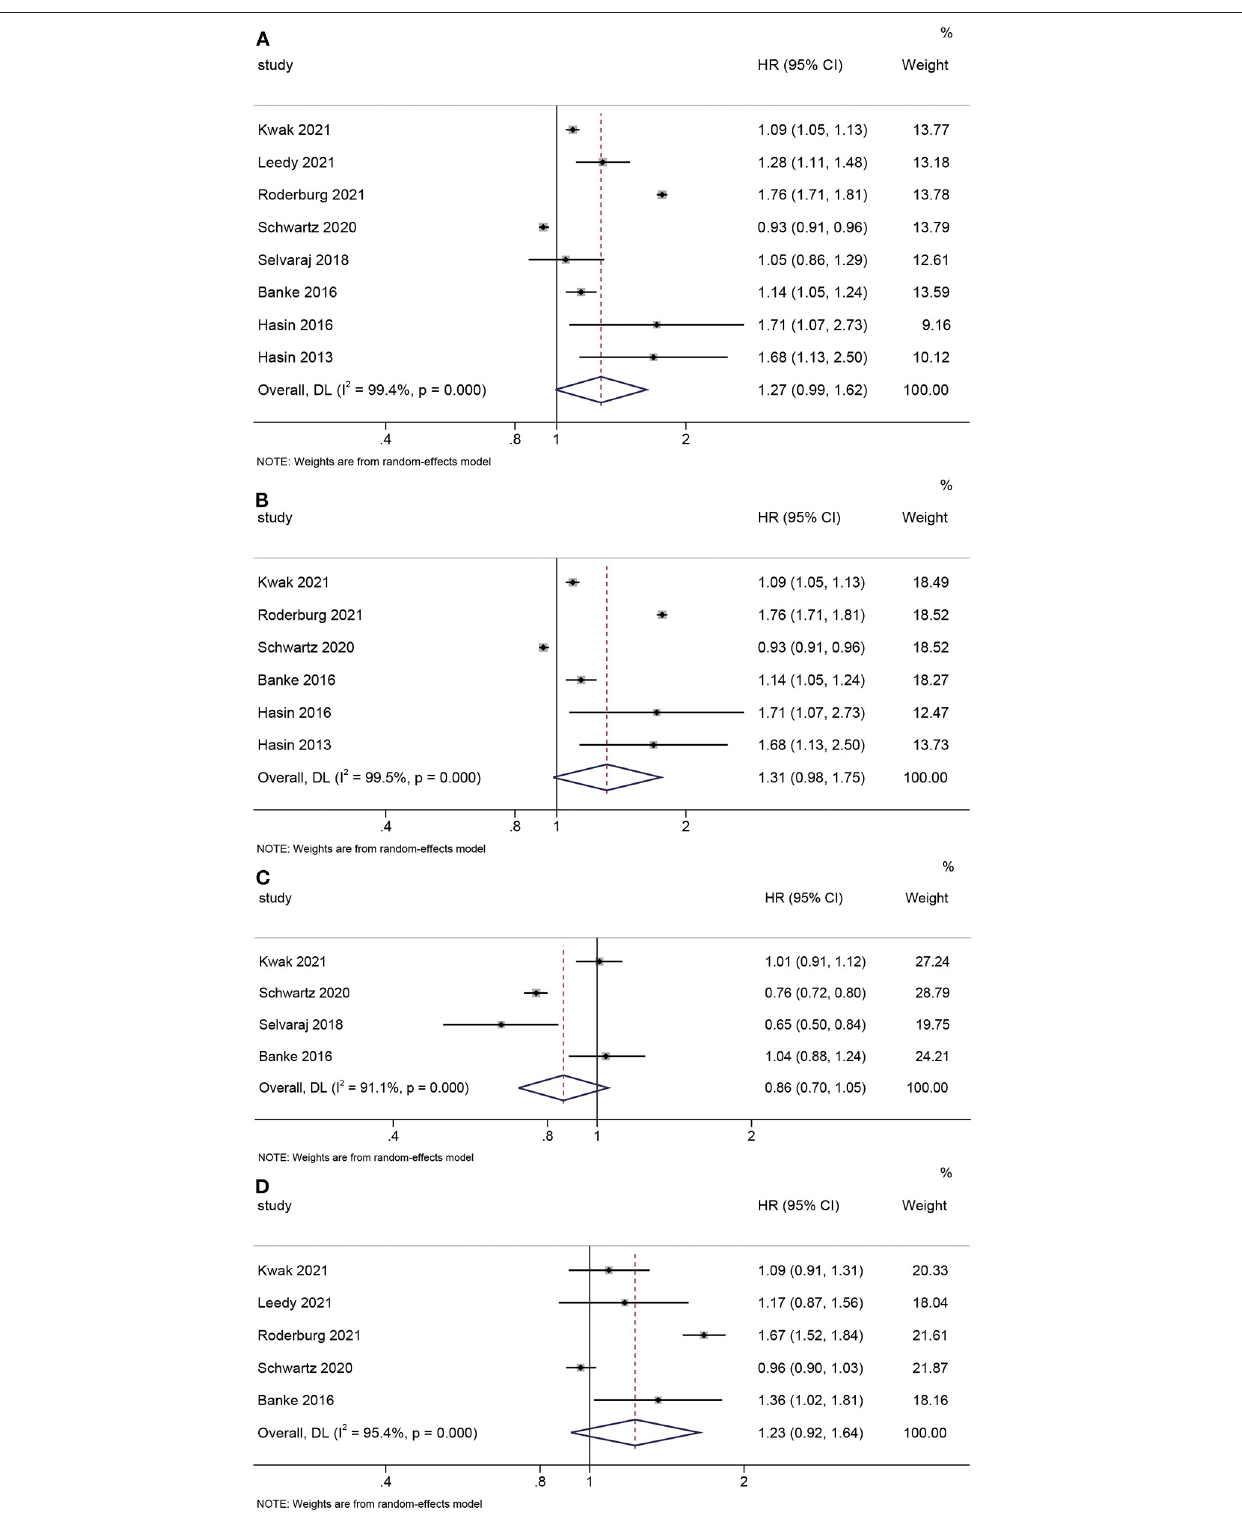
Frontiers in Cardiovascular Medicine | www.frontiersin.org